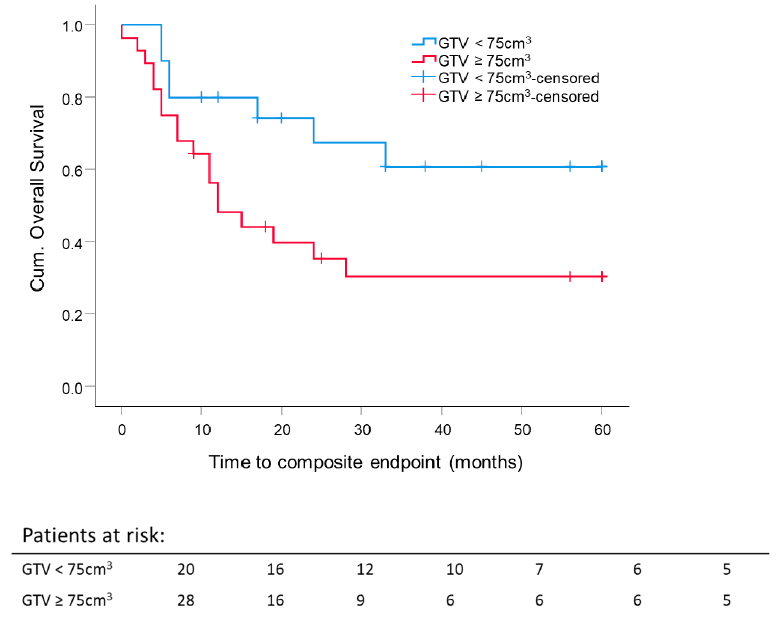
Figure 6. Five-year composite overall survival depending on the GTV: All patients were stratified according to initial GTV, either before surgery or before radiotherapy. Cutoff is 75 cm 3 . Kaplan–Meier curves for each analyzed group were calculated from the date of diagnosis. p = 0.033.